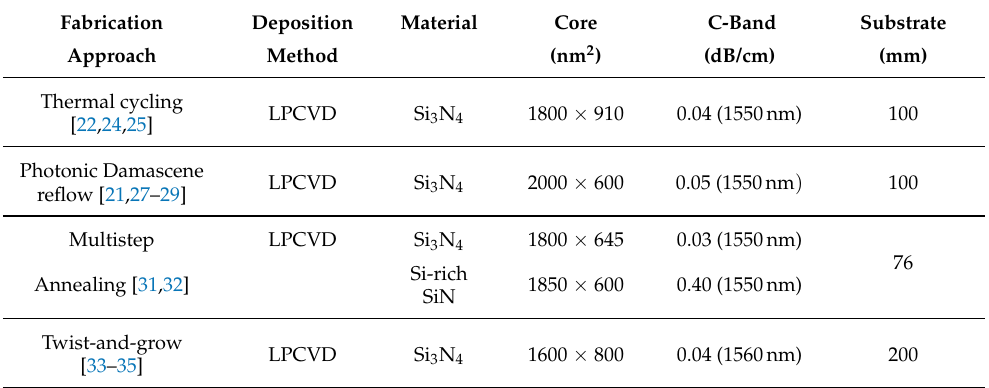
Table 1. Low-loss LPCVD SiN fabrication